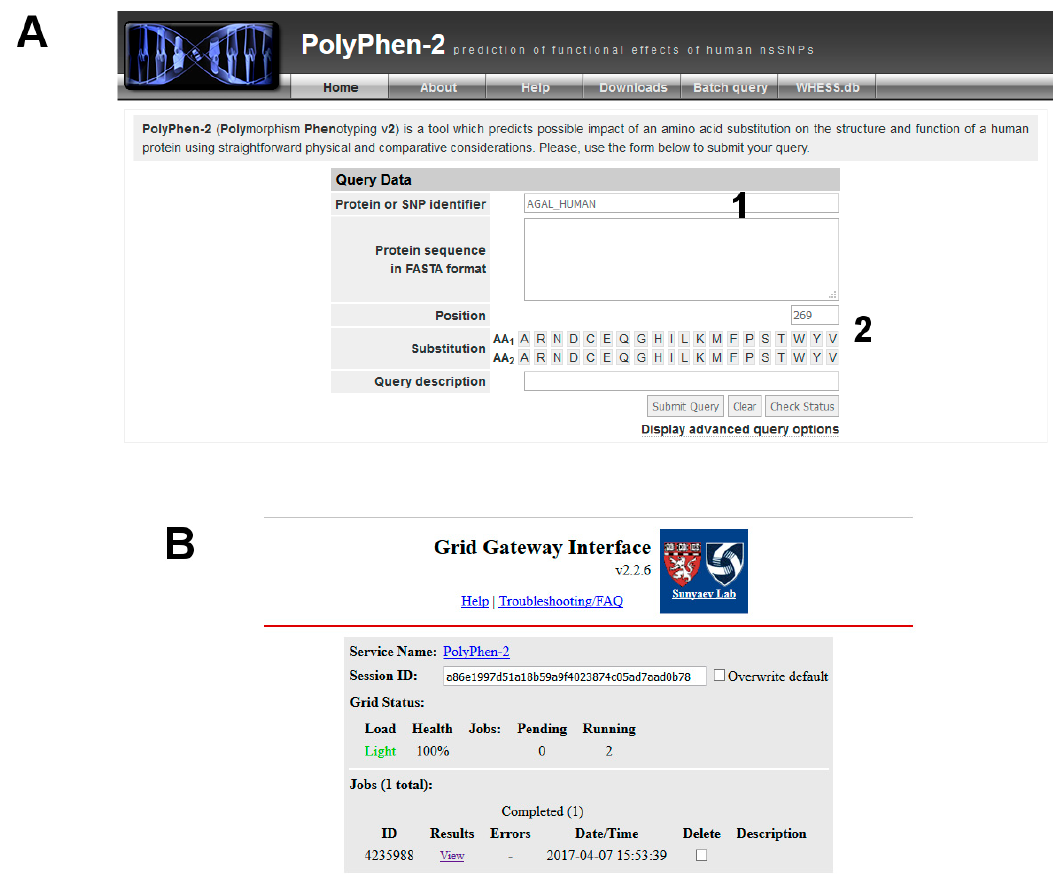
Figure 9. PolyPhen-2 analysis. ( A ) input data and ( B ) result status.